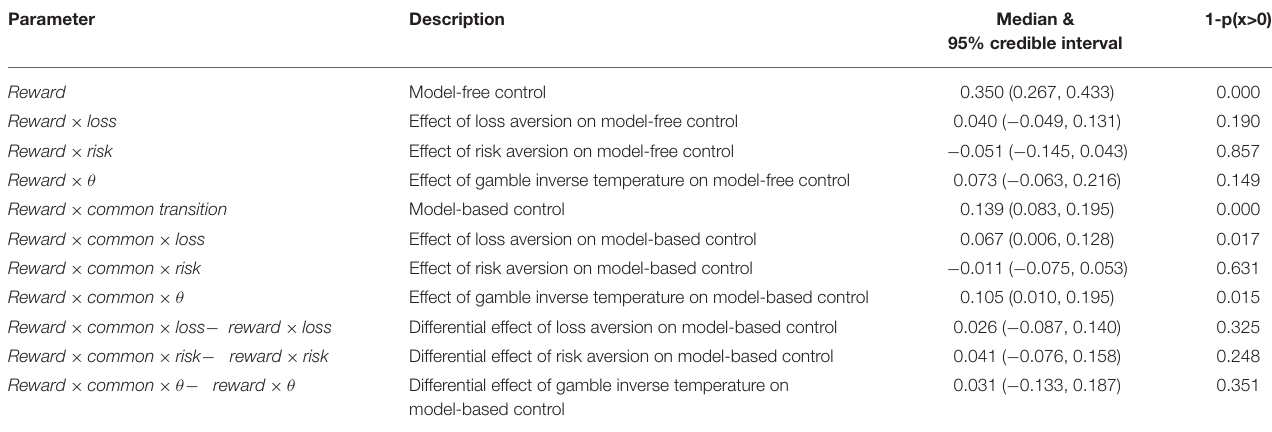
TABLE 1 | Group level estimates of model-based and model-free control in the two-step task, and the effects of the gambling task variables. Parameter